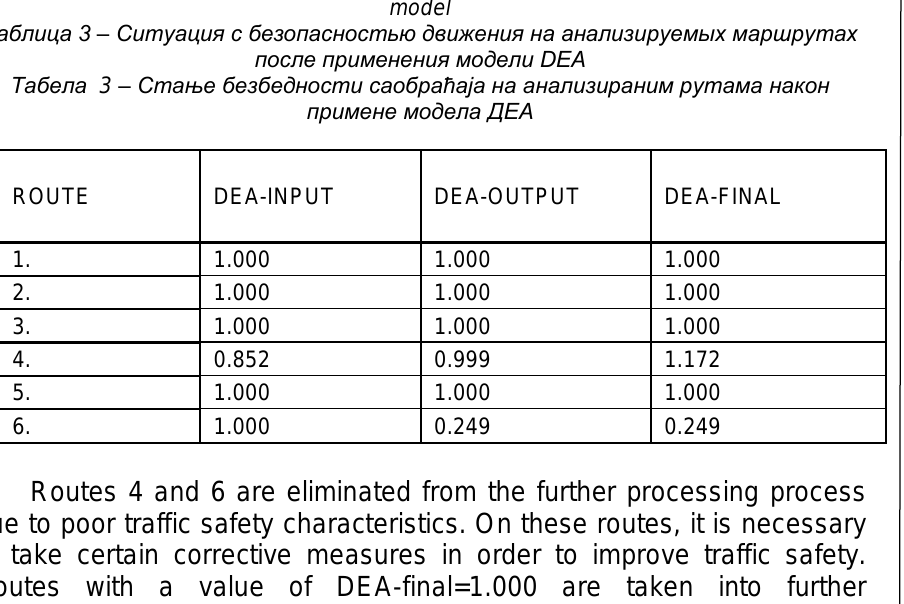
Table 3 – Traffic safety situation on the analyzed routes after the application of the DEA